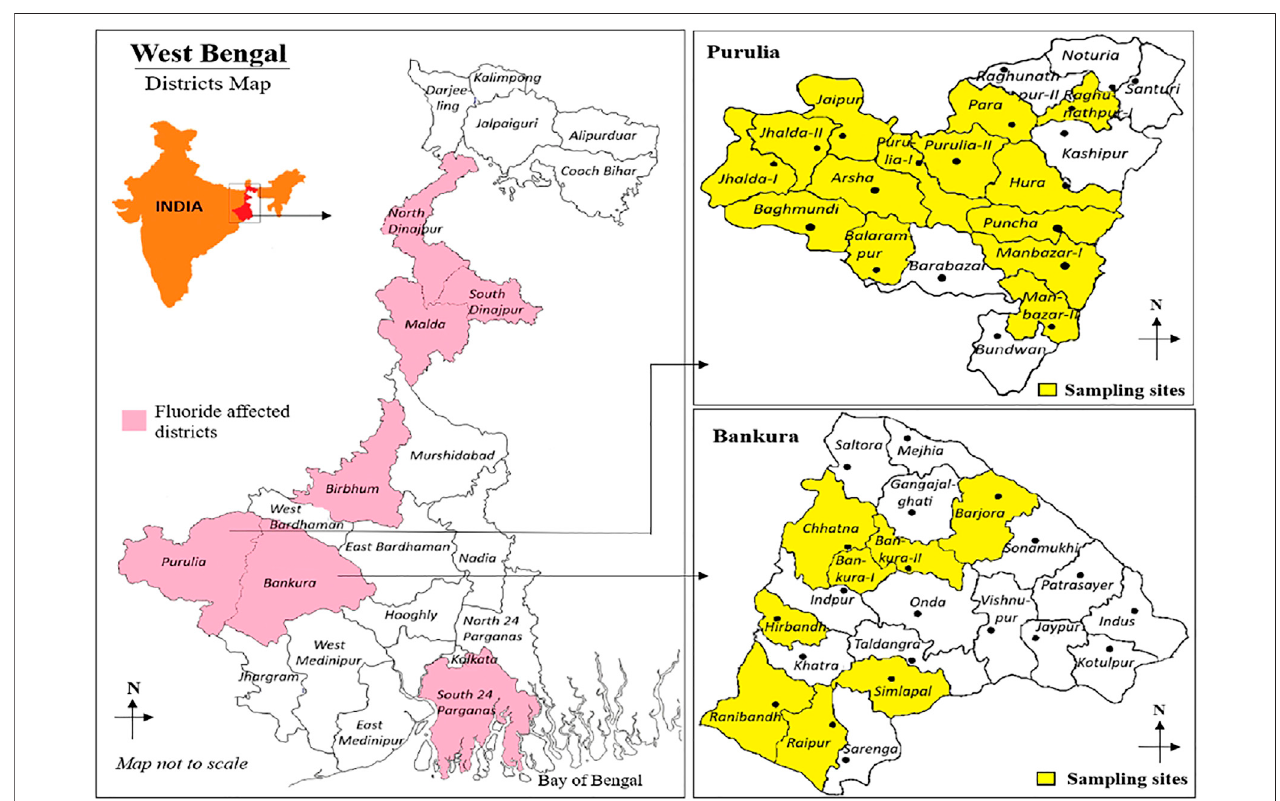
FIGURE 1 | Selected blocks in studied areas of Purulia and Bankura